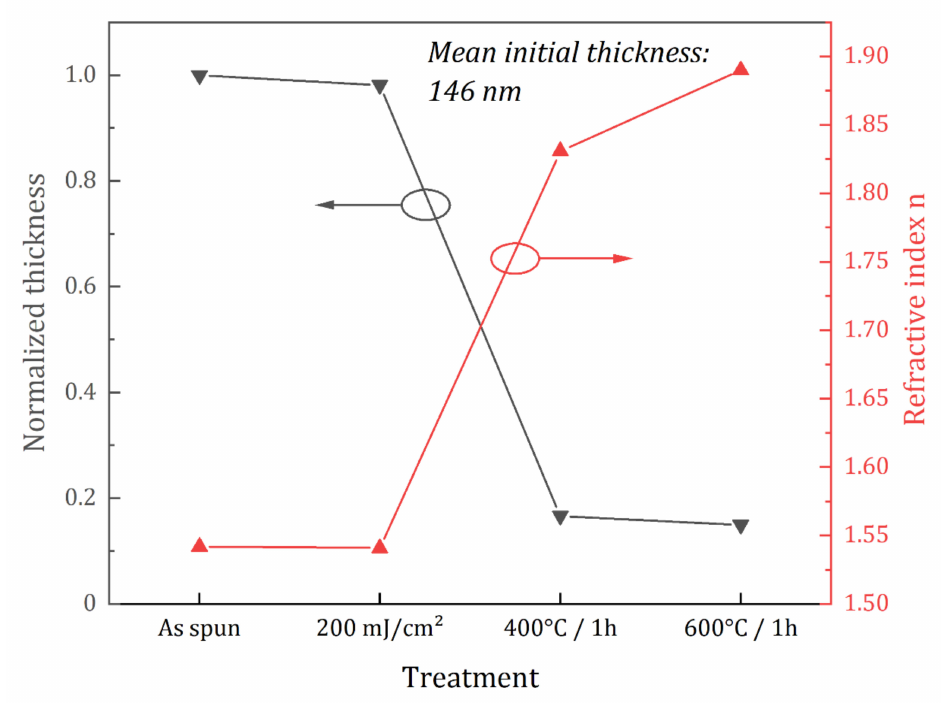
Figure 2. Spectroscopic ellipsometry measurements of the thickness and refractive index of HfO 2-DUV thin films after deposition, after DUV exposure (200 mJ/cm 2 ) and after DUV exposure and thermal annealing (400 ◦ C or 600 ◦